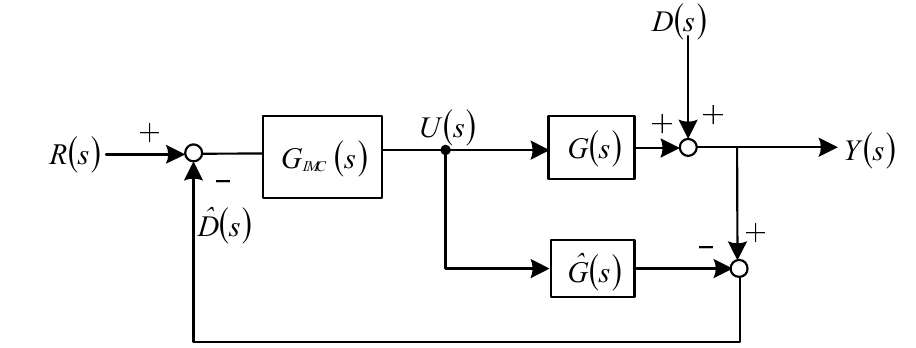
Figure 11. Block diagram of IM-PID control.